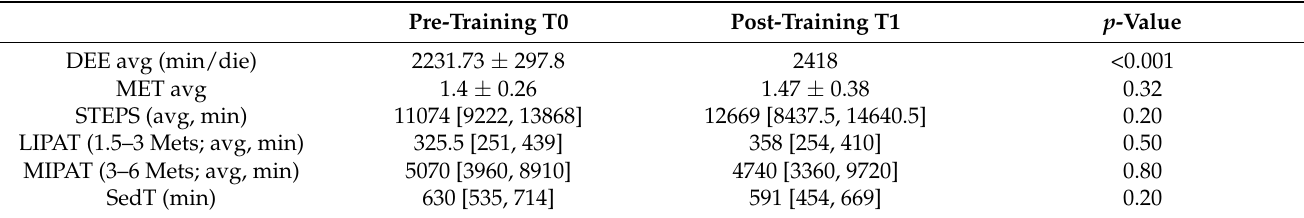
Table 5. Armband analysis of daily spontaneous PhA before (T0) and after training